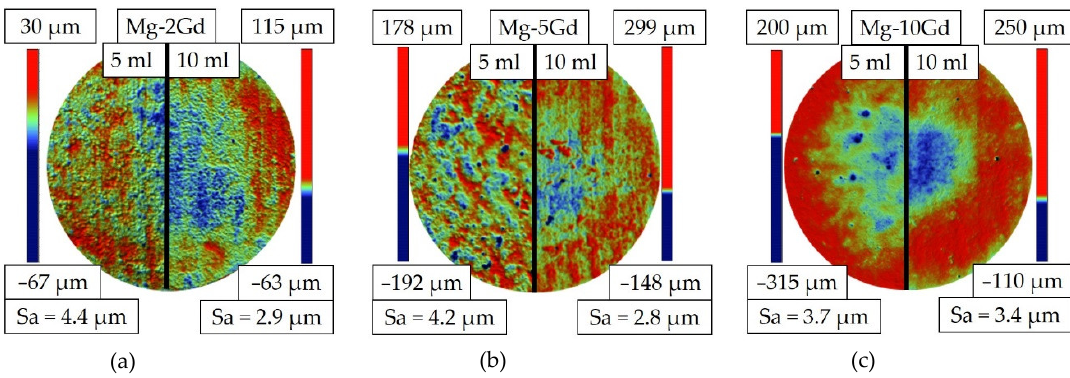
Figure 9. Topographies and their describing parameters of Mg- x Gd alloys measured using WLI after etching with 250 g/L HAc for 150 s; left half image: 5 mL, right half image: 10 mL etching volume, ( a ) topographies of Mg-2Gd; ( b ) topographies of Mg-5Gd; ( c ) topographies of Mg-10Gd.